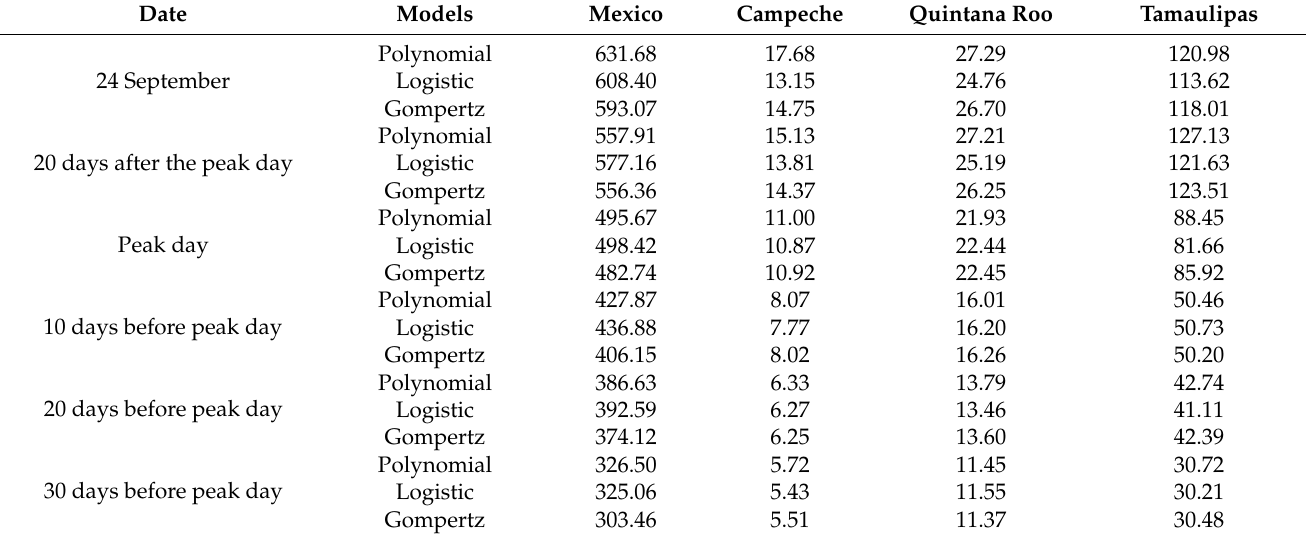
Table 4. Root mean square error (RMSE) values for the four case studies for three different models examined.